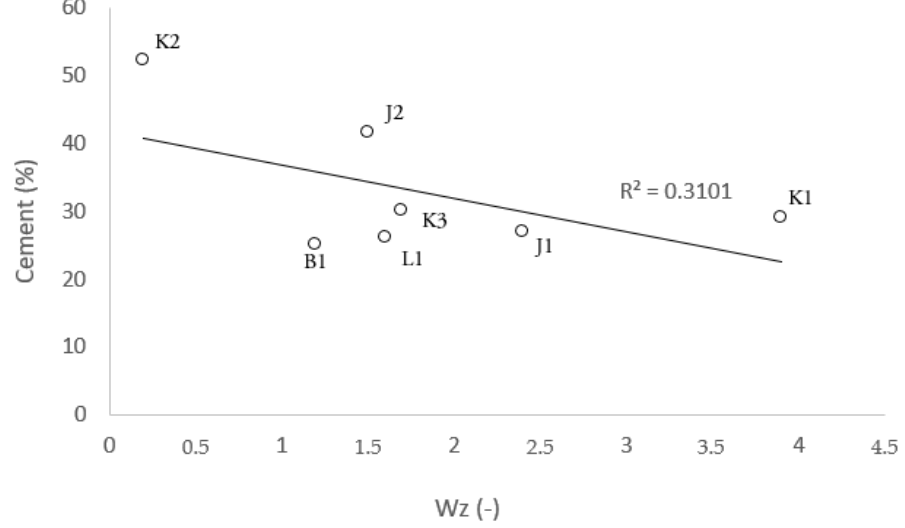
Figure23. Relationship between cement content and abrasivity index W z of tested sandstones . Figure 23. Relationship between cement content and abrasivity index W z of tested